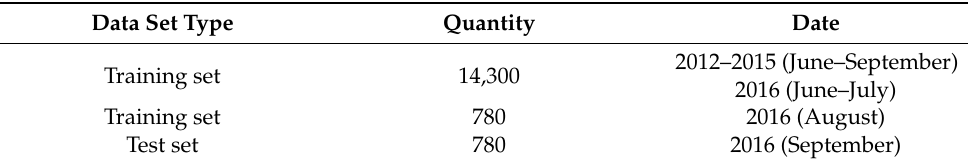
Table 2. Rainy-Model’s data set description.